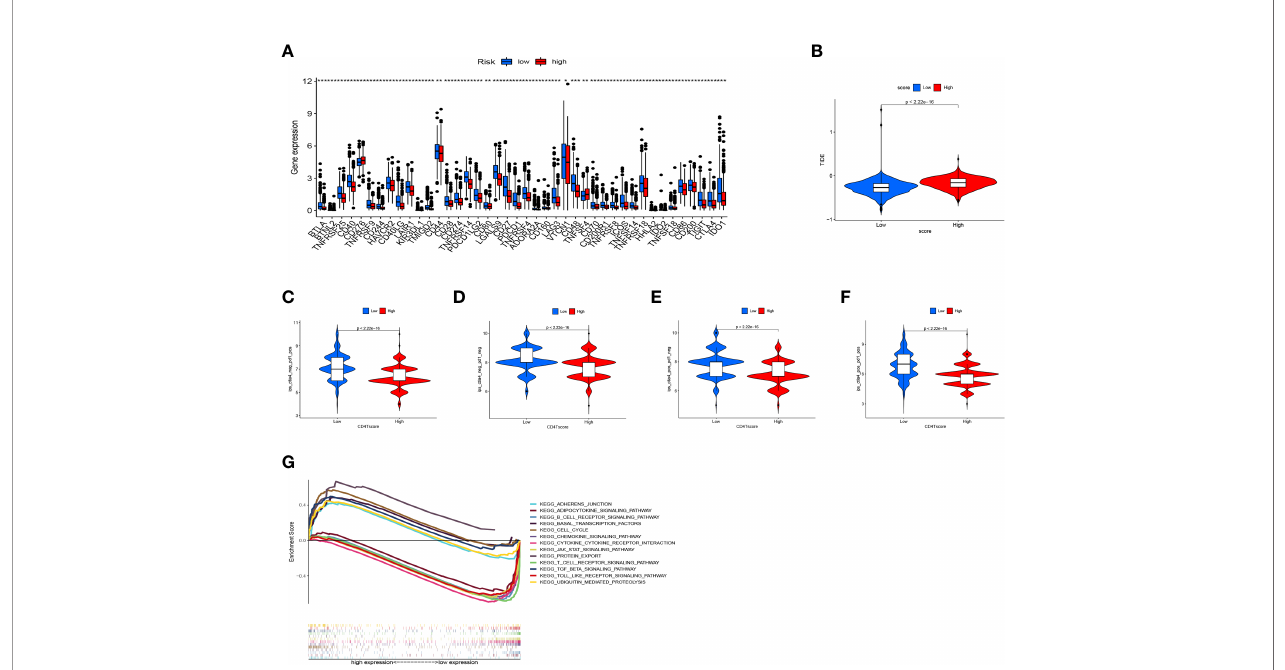
FIGURE 9 | Application of RS in Immunotherapy. (A) Expression levels of immune checkpoints in high- and low-RS groups. (B) Prediction of immunotherapy response based on the TIDE algorithm. IPS score for immunotherapy. (C) CTLA4 − PD1 + . (D) CTLA4 − PD1 − . (E) CTLA4 + PD1 − . (F) CTLA4 + PD1 + . (G) GSEA enrichment analysis results. * P < 0.05, ** P < 0.01, and *** P < 0.001.